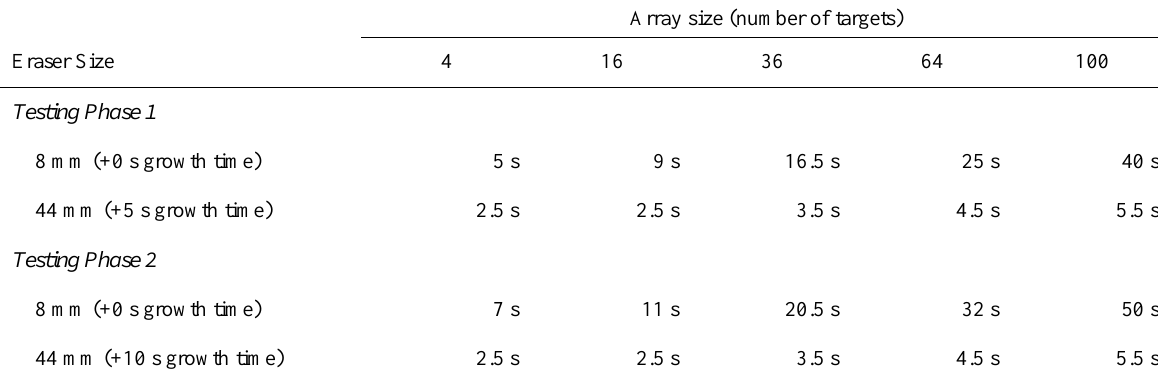
Minimum Time Required to Erase a Target Array as a Function of Eraser Size and Target Array Size